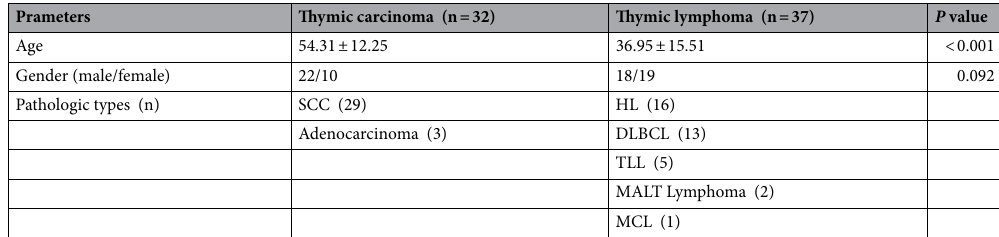
Table 1. Clinical characteristics of the patients. SCC squamous cell carcinoma, HL Hodgkin lymphoma, DLBCL diffuse large B-cell lymphoma, TLL T-cell lymphoblastic lymphoma, MALT Lymphoma Mucosa associated lymphoid tissue lymphoma, MCL Mantle cell